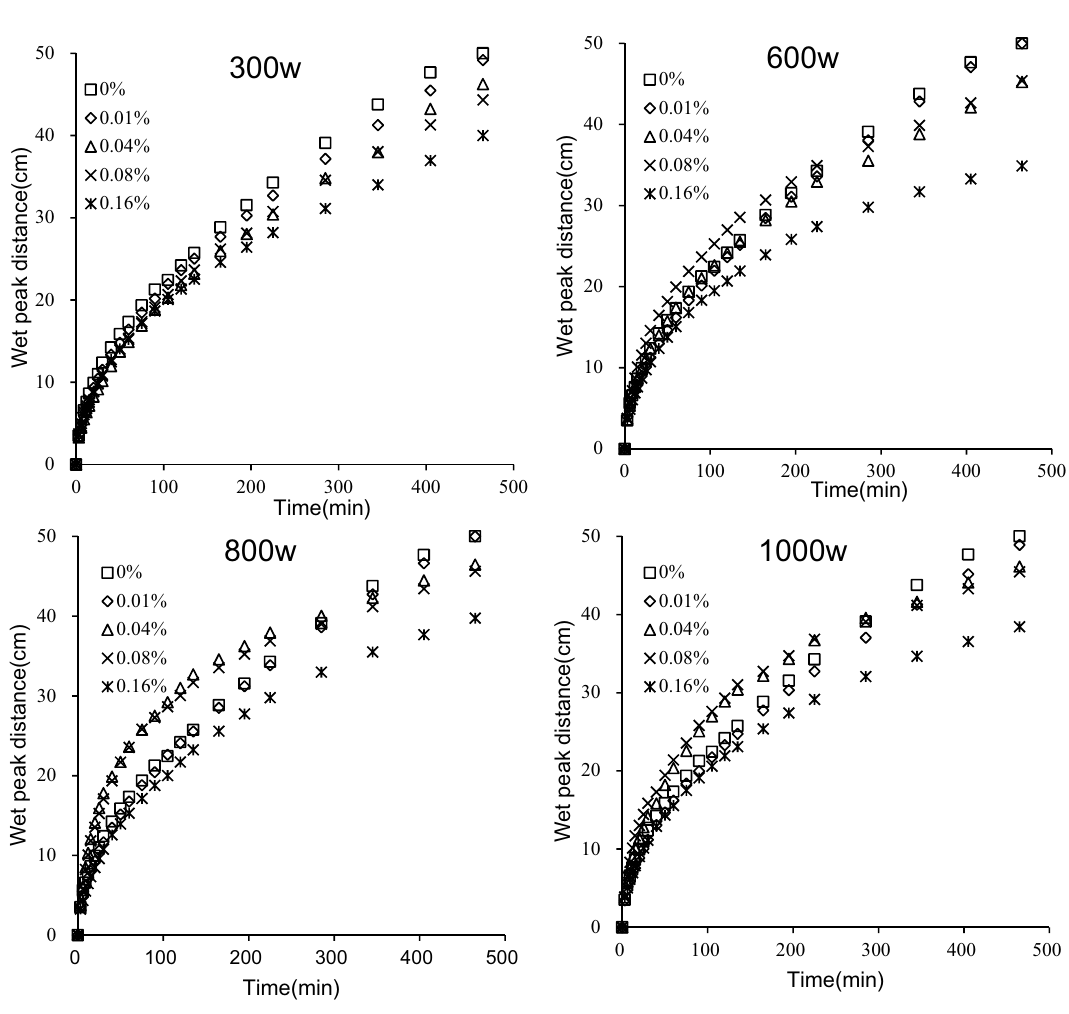
Figure 4. Wet peak distance of iron tailings for four molecular weight (300w, 600w, 800w and 1000w) and five mass concentration (0%, 0.01%, 0.04%, 0.08% and 0.16%) of